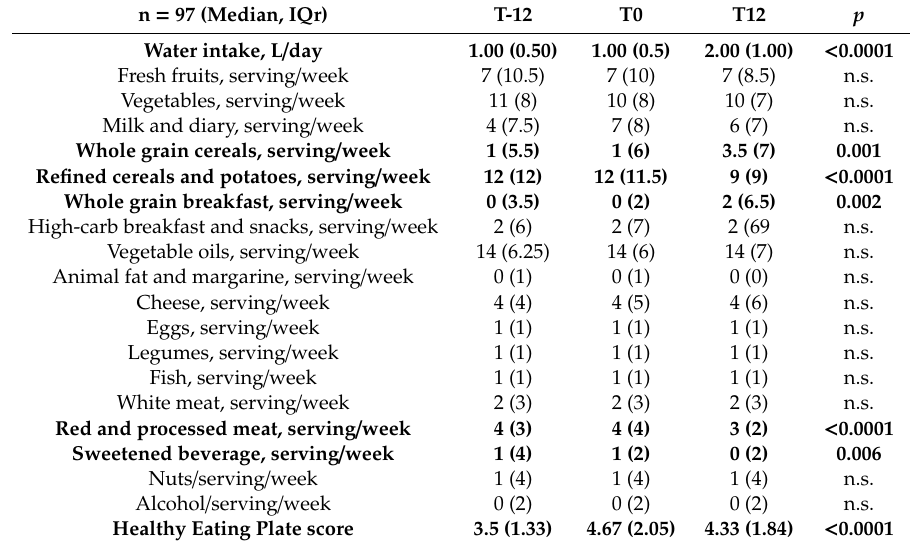
Table 3. Food consumption frequency and the Healthy Eating Plate score along evaluation